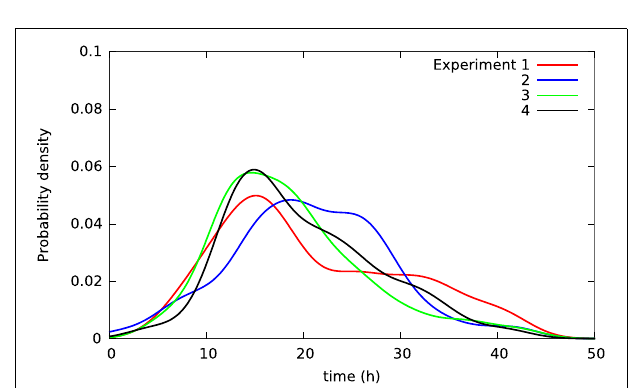
FIGURE 6 | Kernel density estimates of distributions of lifetimes in four separate populations of BC3H1 cells after exposed to 100nM YTX (i.e., each of the four populations were in separate experimental wells) . Influence between cells in the same well may explain the difference between the distributions. These variations between distributions can, therefore, potentially provide measures of such inter-cellular